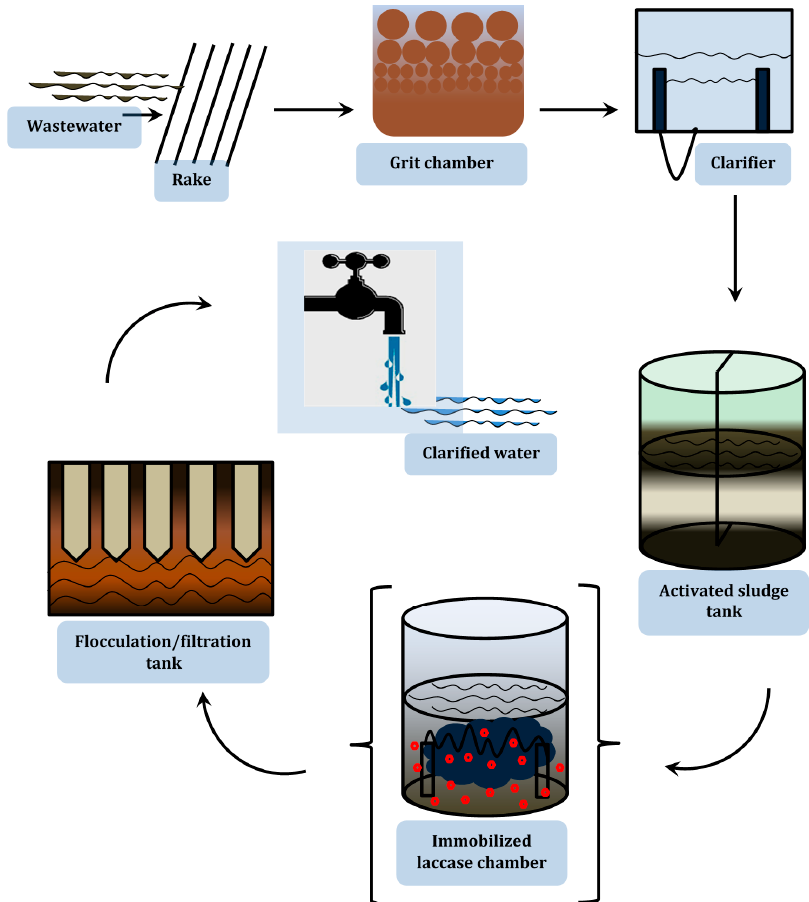
Figure 6. Schematic of a typical conventional wastewater treatment process showing the prospective strategic position of laccase treatment. The laccase immobilization chamber comprises a pretreated lignocellulosic support, which possesses antimicrobial properties. The location of the chamber helps to reduce or totally eliminate aromatic pollutants that could interfere with the efficiency of the flocculation step.